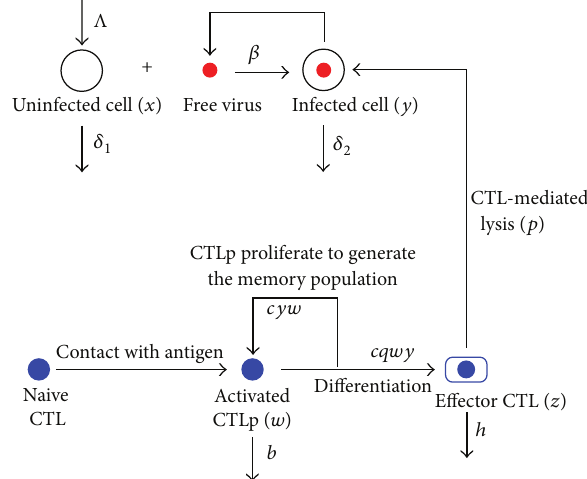
Figure 1: A simplified model of virus-CTL interaction. The virus dynamics is described by the basic model of Nowak and Bangham [19]. The uninfected target cells are produced at a rate Λ and die at a rate 𝛿 1 𝑥 . They become infected by the virus at a rate 𝛽𝑥𝑦 . The infected cells produce new virus particle and die at a rate 𝛿 2 𝑦 . When CTL 𝑝 recognize antigen on the surface of infected cells, they become activated and expand at a rate 𝑐𝑦𝑤 , decay at a rate 𝑏𝑤 , and differentaite into efector cells at a rate 𝑐𝑞𝑤𝑦 . The effector cells lyse the infected cells at a rate 𝑝𝑦𝑧